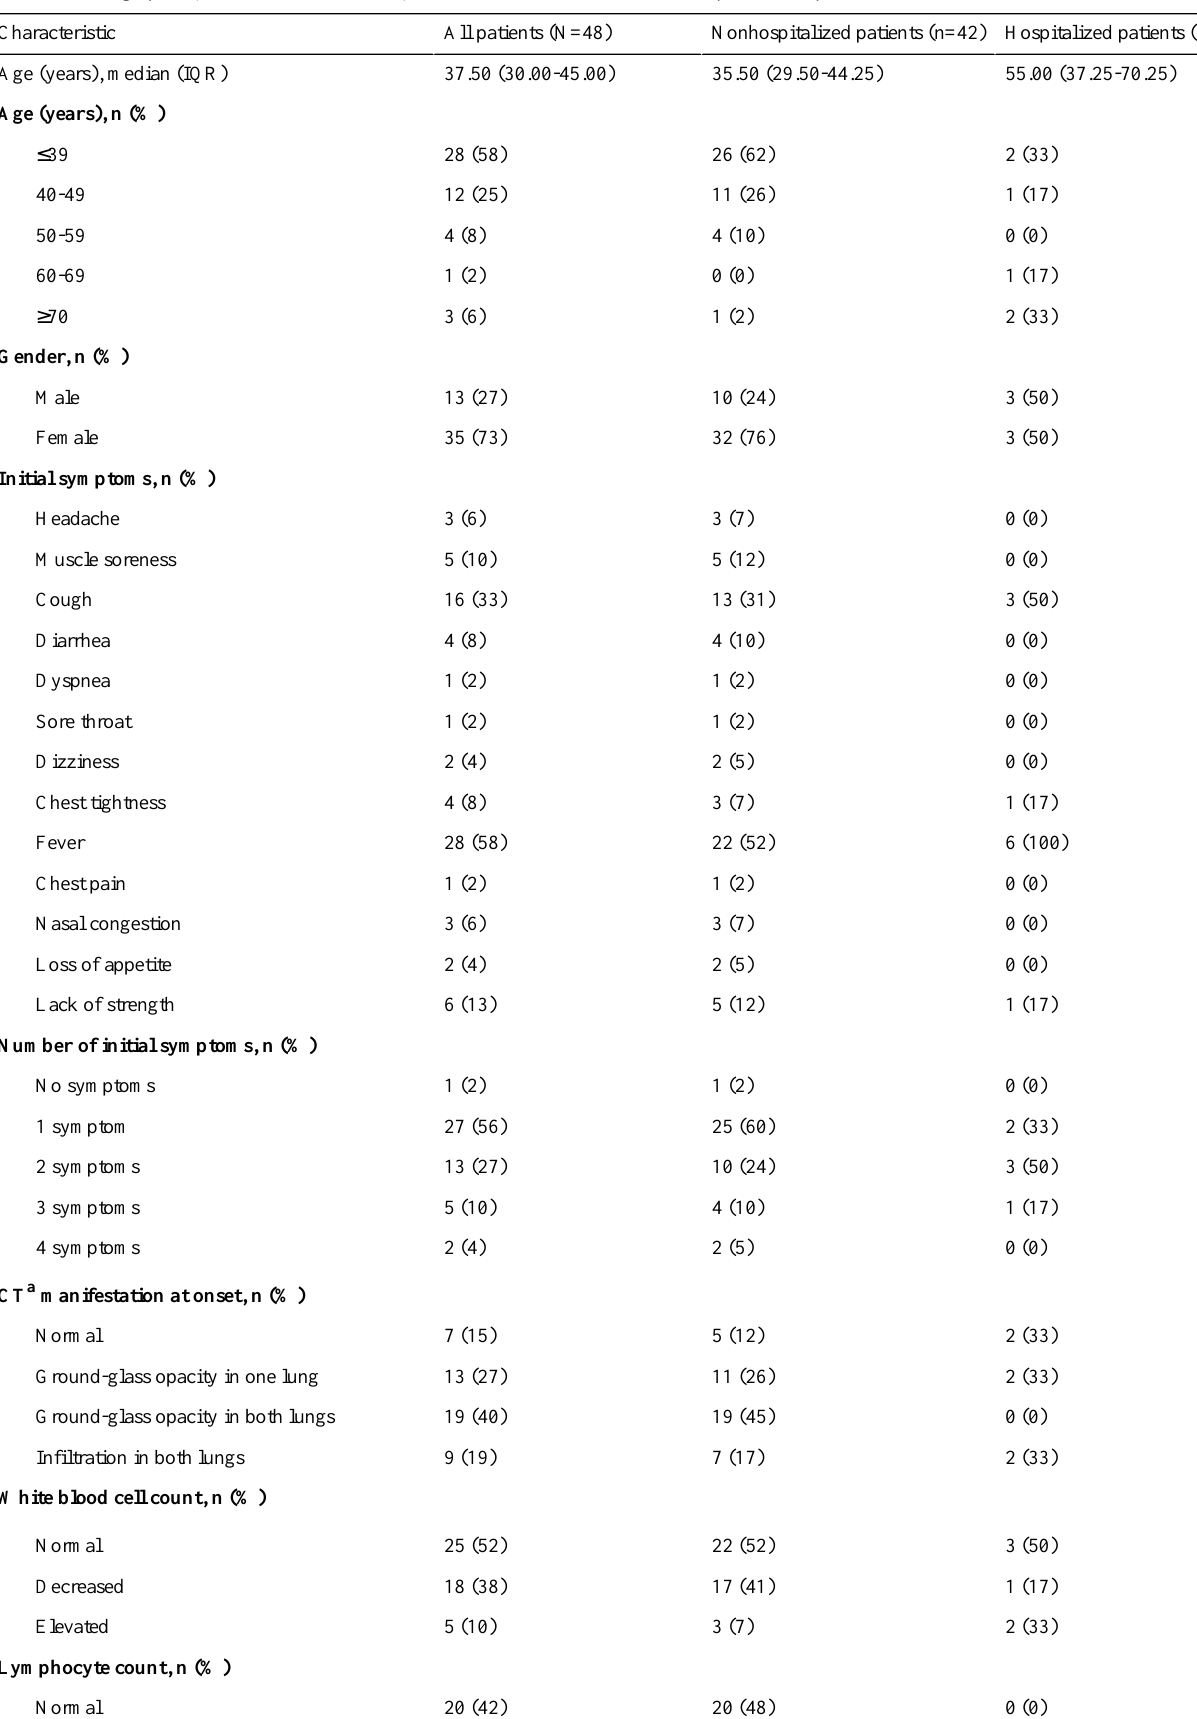
Table 1. Demographics, baseline characteristics, and clinical outcomes of the home-quarantined patients with COVID-19